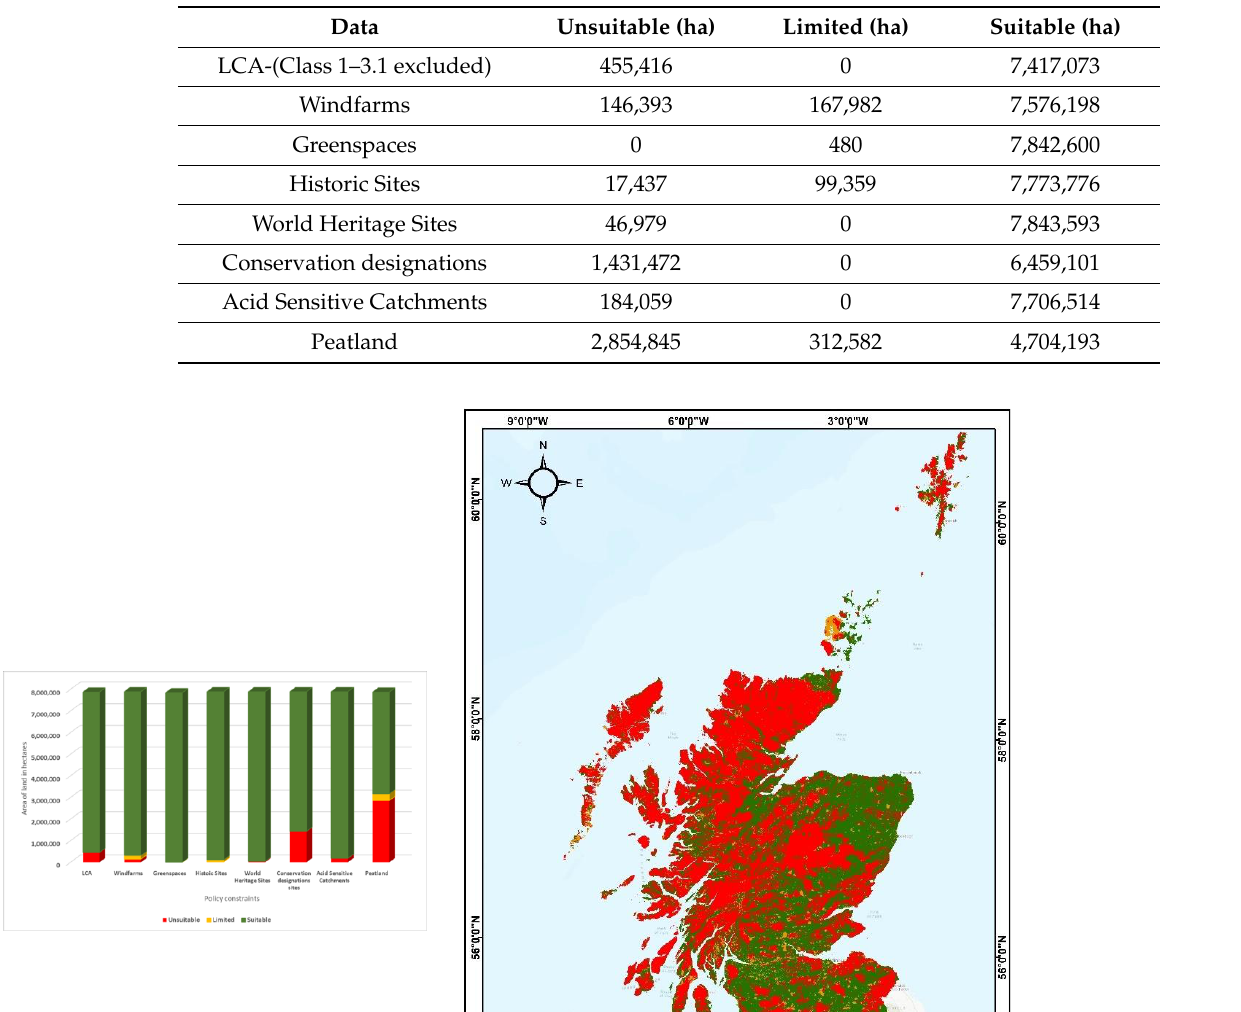
Table 8. Unsuitable/limited/suitable areas based on current policy constraints in Scotland.